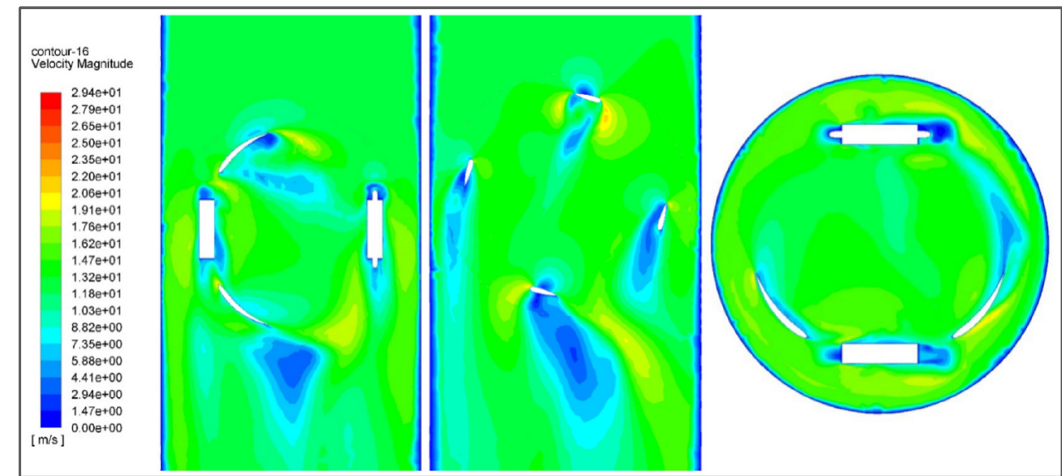
Figure 17. Velocity contour of the turbine showing the variation in fluid velocity along the mesh. Pressure contour shows the relative change in pressure with the continuous notion. It shows the pressure gradient with respect to the flow direction before and after the impact. Pressure contours are obtained by pressure measurements translated into average cross-sectional. Figure 18 shows the pressure contour of the turbine in all views possible. It implicitly explains the change in static pressure of the fluid. It decreases significantly right after the impact with the blade, indicating the transfer of energy from fluid to the turbine.